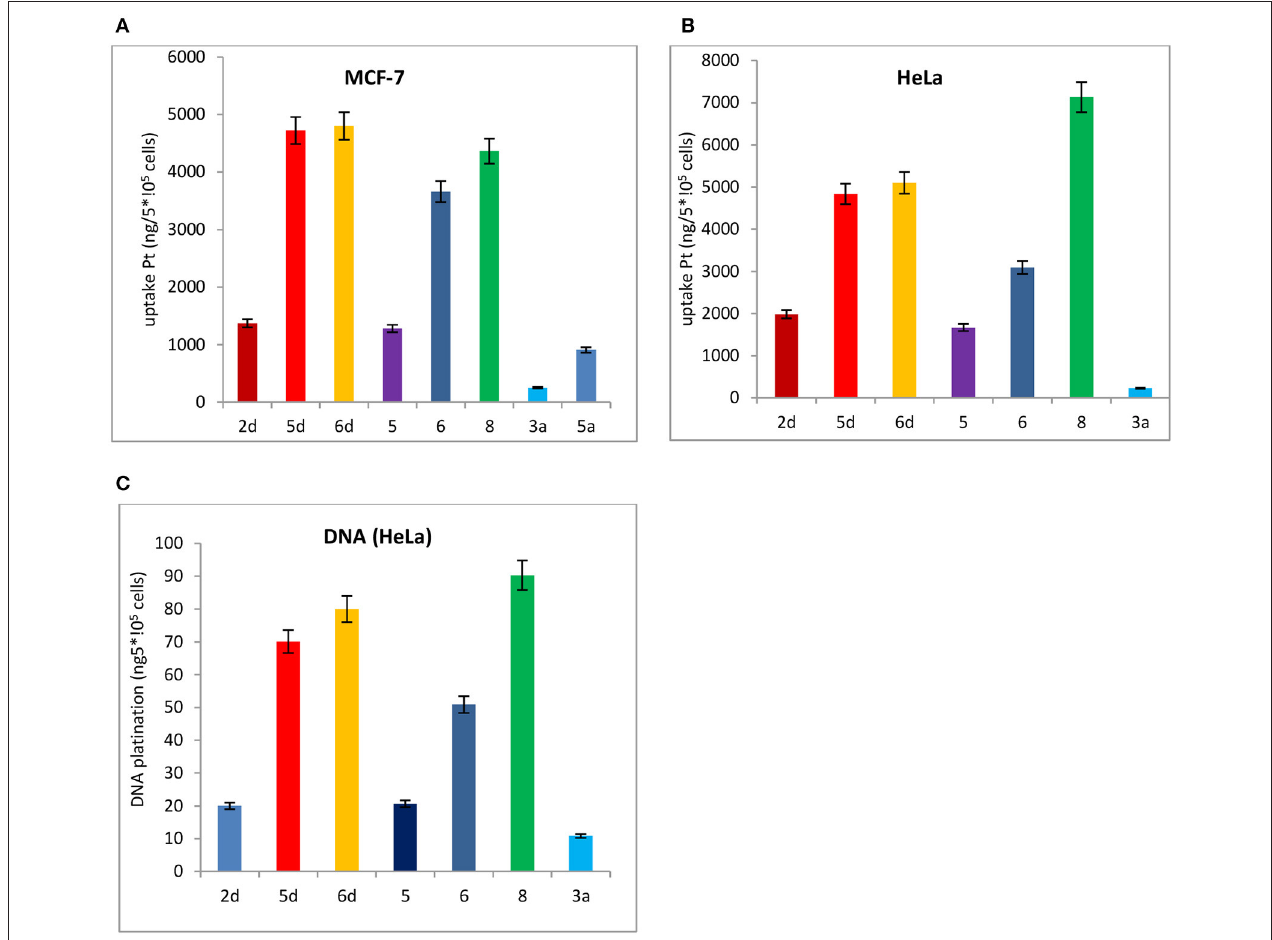
FIGURE 7 | Cell uptake and DNA platination of 2d, 5d, 6d, 5, 6, 8, 3a , and 5a . (A) Cell uptake of 2d, 5d, 6d, 5, 6, 8, 3a , and that the compound was in MCF-7 cells. (B) Cell uptake of 2d, 5d, 6d, 5, 6, 8, 3a, and 5a in HeLa cells. (C) DNA platination of 2d, 5d, 6d, 5, 6, 8, 3a , and 5a isolated from HeLa